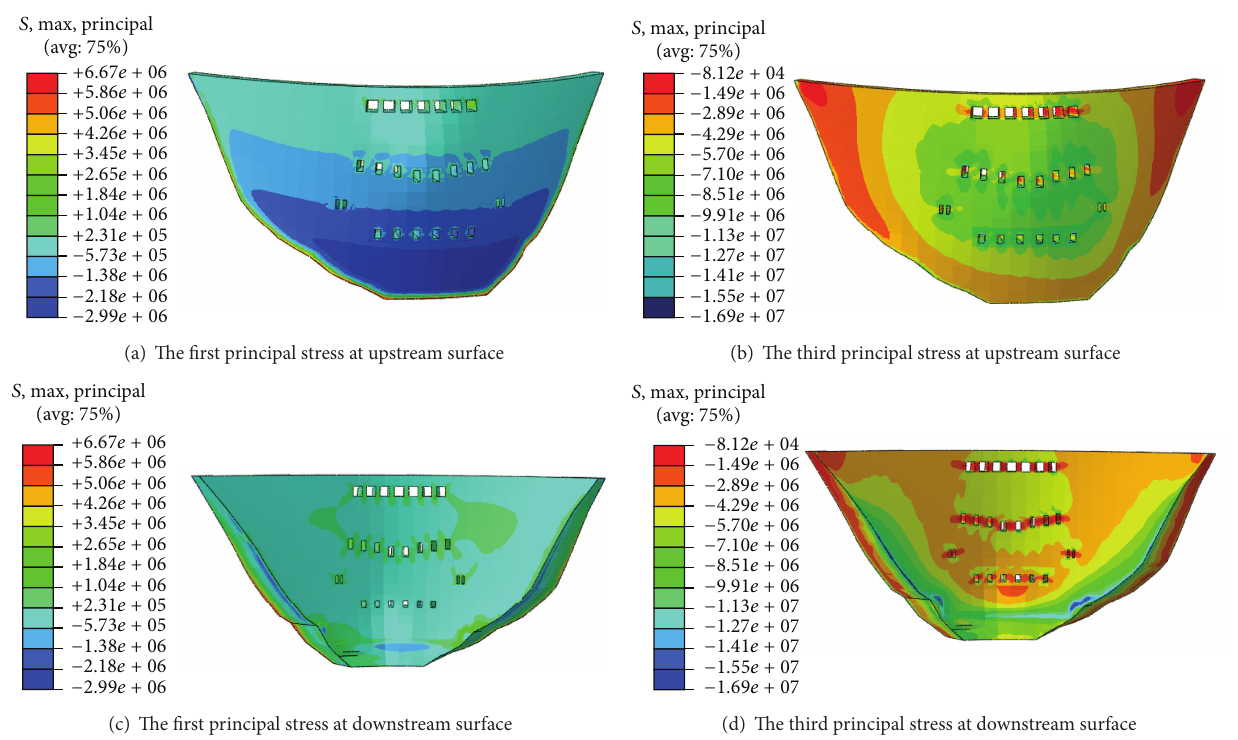
Figure 8: The principal stress distribution (analysis case A; Unit: pa; “ − ” denotes compression stress, and “+” denotes tension stress).